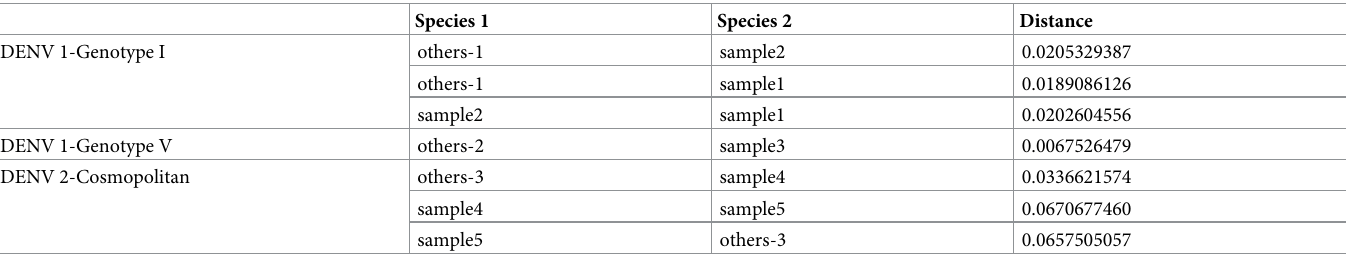
Table 4. Comparison of average genetic distances of different clusters.